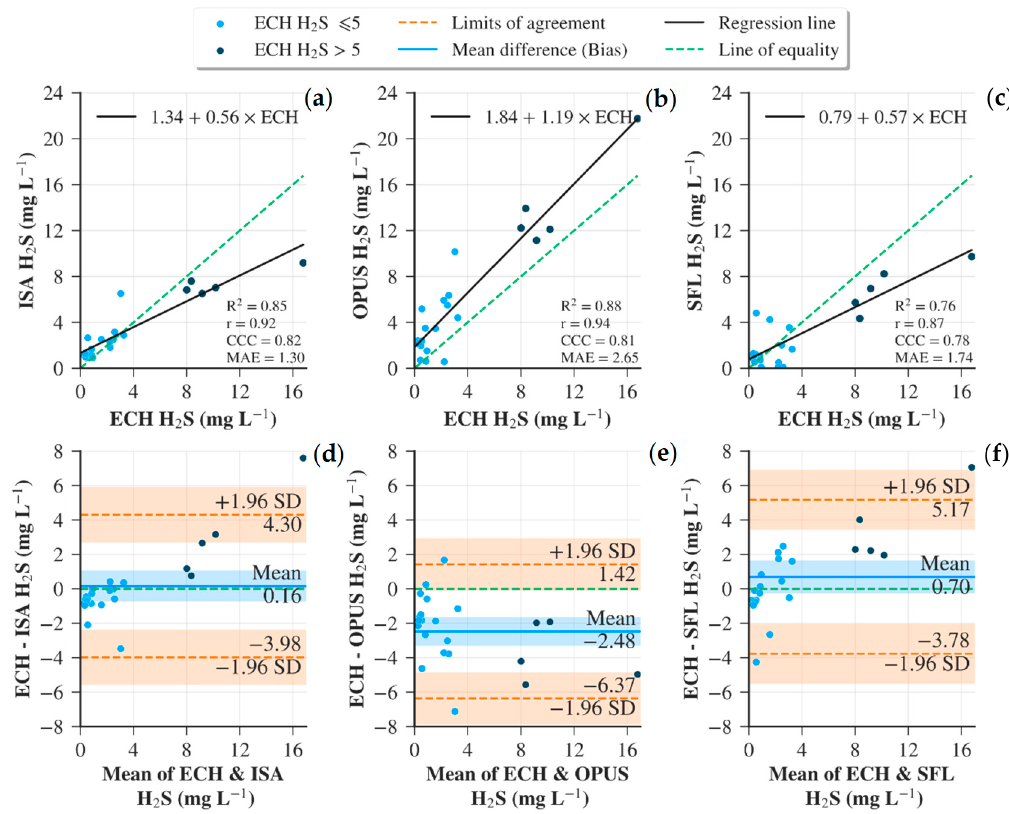
Figure 2. Correlation plots between the reference (ECH) and sensors’ (ISA, OPUS, and SulfiLogger TM (SLF)) measurements ( a – c ). Bland-Altman plots for comparison pair (ECH vs. ISA, ECH vs. OPUS, and ECH vs. SLF) ( d – f ). The x -axis shows the mean of the reference and sensor measurement. The y -axis corresponds to the difference between the reference and sensor measurement.